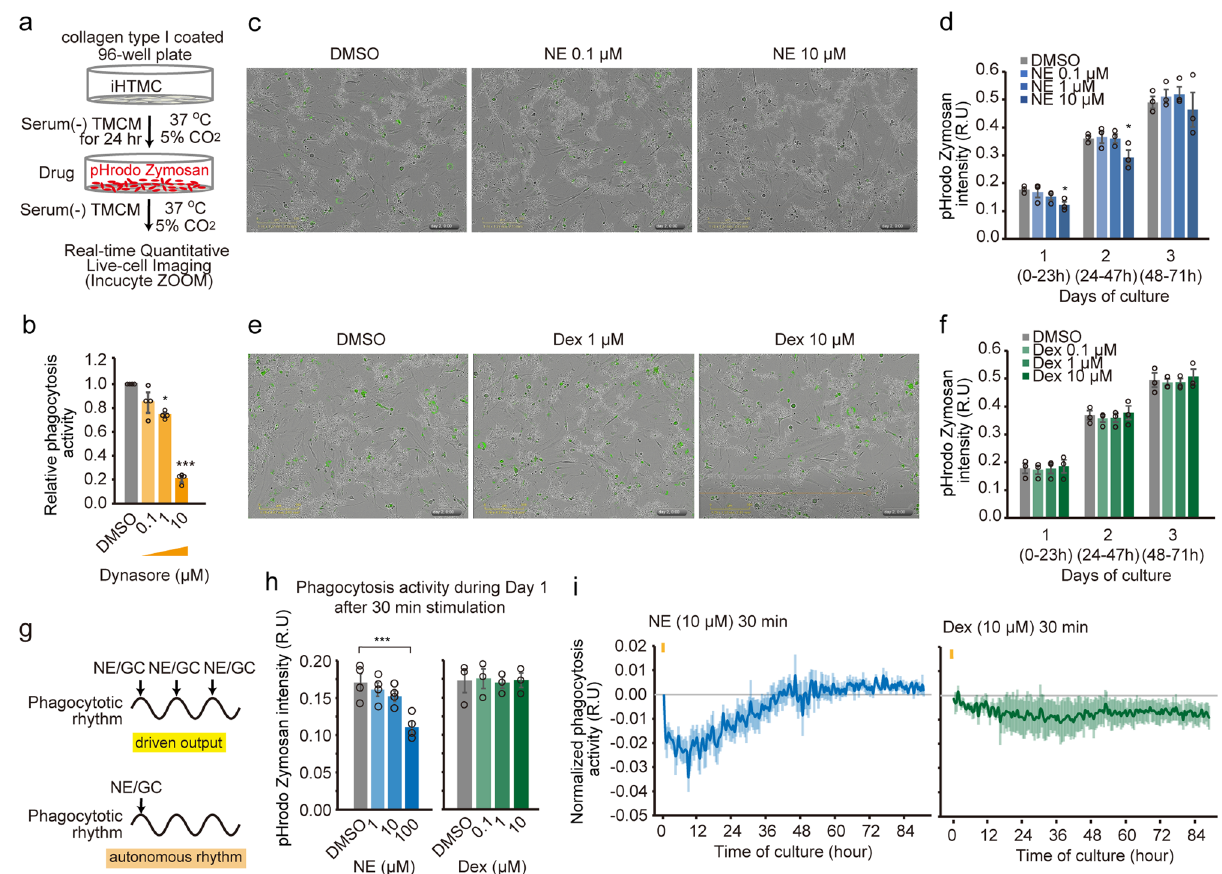
Fig. 3 Driven-output stimuli of norepinephrine may suppress phagocytosis in iHTMC. a Immortalized human TM cells (iHTMC) were placed on type I collagen-coated plates, and after 24 h, pH-sensitive pHrodo Zymosan was added with norepinephrine (NE) and dexamethasone (Dex) to evaluate phagocytosis in real time over 3 days. b This ability was con fi rmed by the phagocytosis inhibitor, Dynasore (* p < 0.05, *** p < 0.001 vs. DMSO, one-way ANOVA [ p < 0.001], Dunnett ’ s multiple comparison). Data are presented as scatter plots with mean ± SEM ( n = 3 independent experiments). Representative images 24 h after medium changes including NE or Dex (0.1, 1, and 10 µ M) ( c , e ), and quanti fi ed phagocytic activity ( d , f ). Scale bar = 300 μ m. Continuous NE exposure dose-dependently prevented phagocytic activity in iHTMC during 2 days of culture (* p < 0.05 vs. DMSO, one-way ANOVA [ p < 0.01], Dunnett ’ s multiple comparison) ( d ), but not Dex ( f ). Data b , d , f are presented as scatter plots with mean ± SEM ( n = 3 independent experiments). g driven output regulation, or self-sustainable regulation after a single stimulation in diurnal phagocytosis changes. h , i Exposure to NE (1, 10, and 100 µ M) or Dex (0.1, 1, and 10 µ M) stimulation for 30 min to iHTMC and real-time phagocytic activity was observed in iHTMC for 3 days. Although we did not observe any circadian phagocytosis rhythm in the normalized fl uorescence signal, a high NE pulse stimulation (yellow bar; 10 µ M) suppressed phagocytosis for about 1 day (*** p < 0.001 vs. DMSO, one-way ANOVA [ p < 0.001], Dunnett ’ s multiple comparison) ( h , i ), which was later restored to normal level ( i ), but Dex pulse stimulation (yellow bar; 10 µ M), did not modulate phagocytosis rhythm ( h , i ). Data are presented as bar graphs (mean ± SEM) with scatter dot plots ( h ) and mean ± SEM ( i ) of independent experiments ( n = 3 –